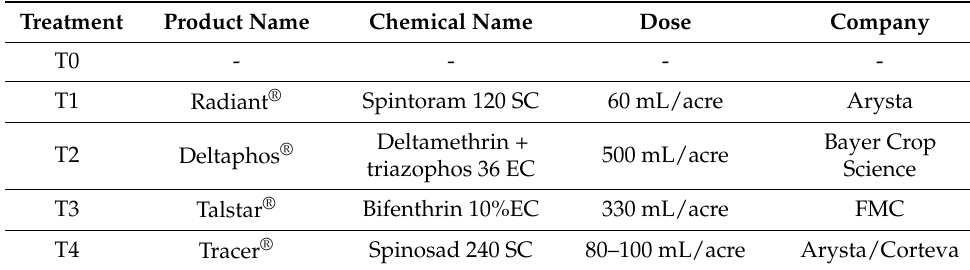
Table 1. List of insecticide used against tomato leaf